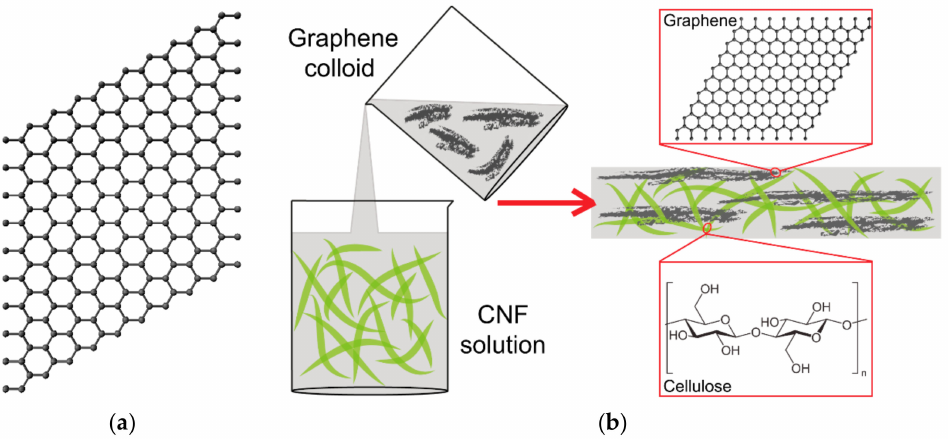
Figure 2. Scheme of graphene ( a ) and of the preparation and structure of nanocellulose / graphene composites ( b